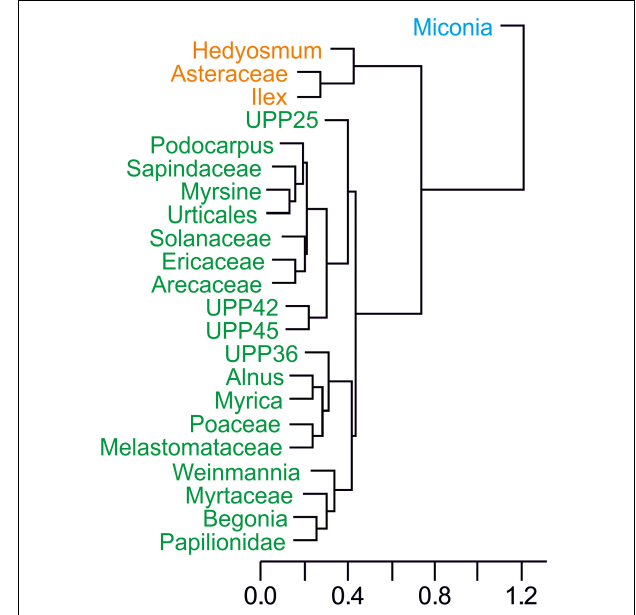
FIGURE 4 | Cluster analysis through the “average” method of the most abundant pollen taxa found in Laguna Pindo during the glacial interval. Colours define the groups resulted: Group 1 (blue), Group 2 (orange), and Group 3